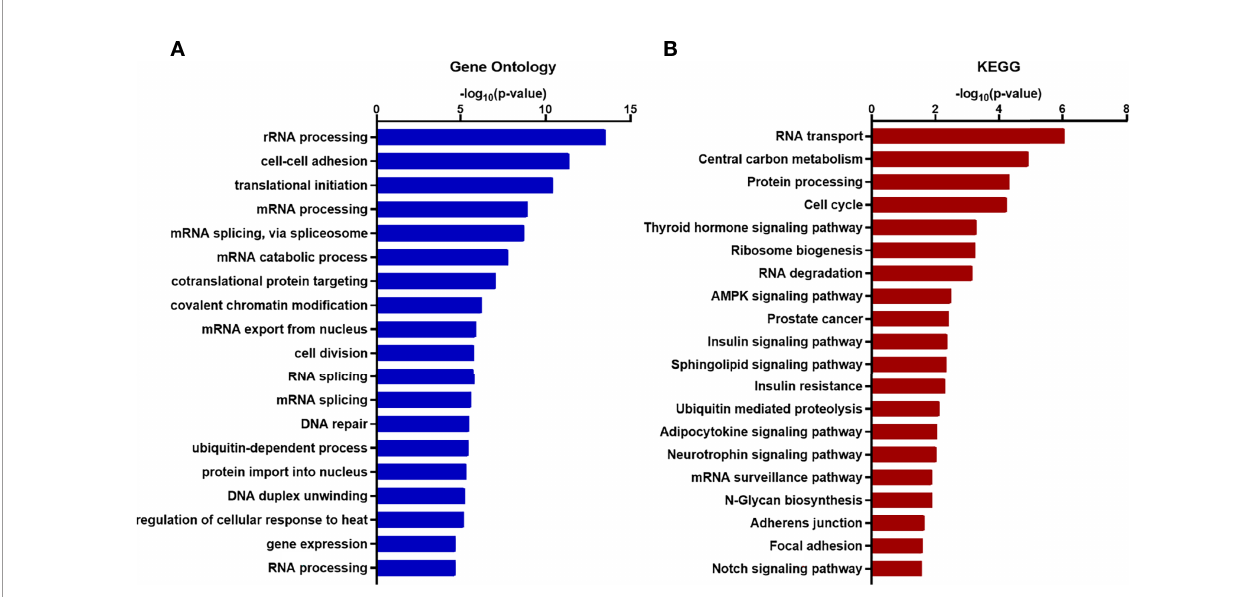
FIGURE 6 | Functional enrichment and annotation of genes associated with XIST via bioinformation software. (A) GO annotation and (B) KEGG pathway enrichment analysis of XIST genes shown in blue and red, respectively. The original signi fi cance values obtained from DAVID were transformed to “ -log (p-value) ” for plotting. Functions and/or pathways with the highest signi fi cance are